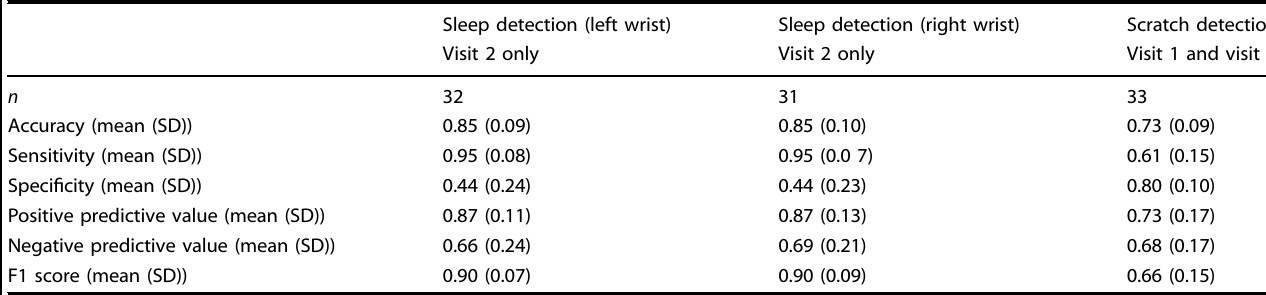
Table 2. Summary statistics on epoch level classi fi cation of sleep (30 s) and scratch (3